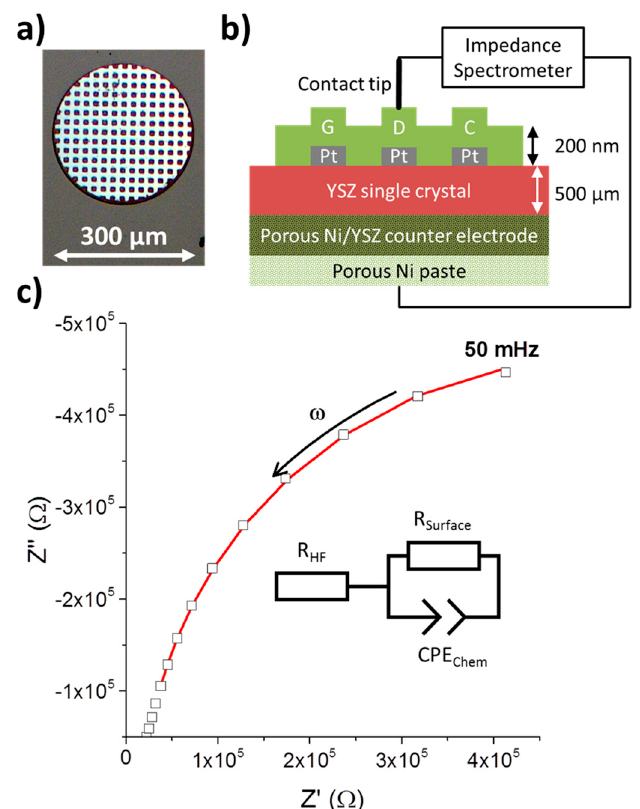
Figure 1. ( a ) Optical micrograph of a circular Pt/GDC 10 composite microelectrode. The bright grid is a 100 nm thick Pt current collector of 10 µm width and with 10 × 10 µm 2 holes beneath a 200 nm GDC 10 thin film; ( b ) Schematic cross sectional view of a Pt/GDC microelectrode setup wired for impedance measurement; ( c ) Electrical impedance spectrum (squares) with data fitting ( red line) to the equivalent circuit shown. The medium frequency part is not considered in the data fitting, see Section 2.11.